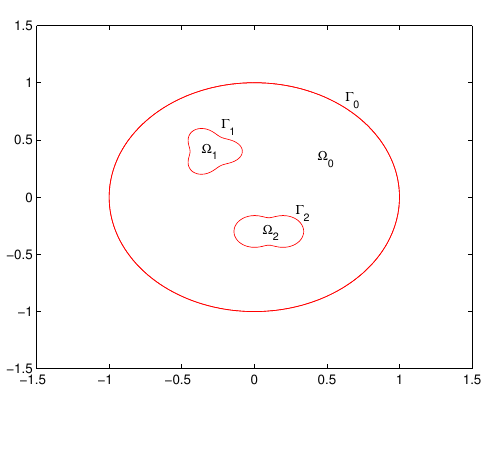
Figure 1. Example of a configuration